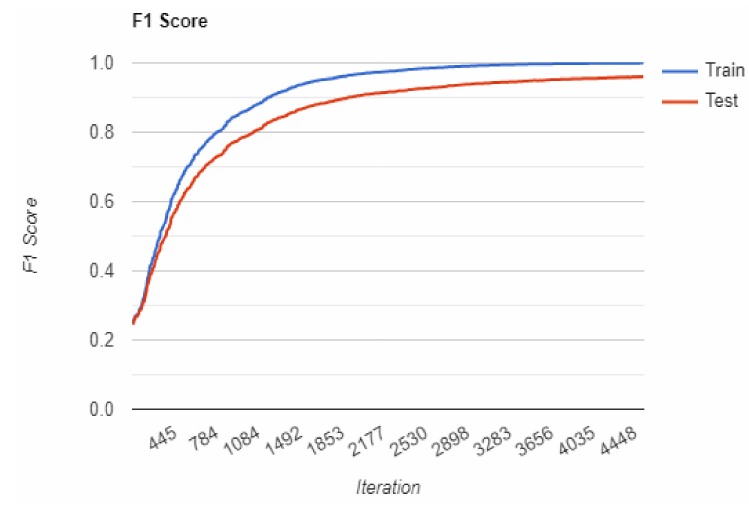
Figure 12. Iteration vs. F1 score. F1 score continuously increases as the training progresses.